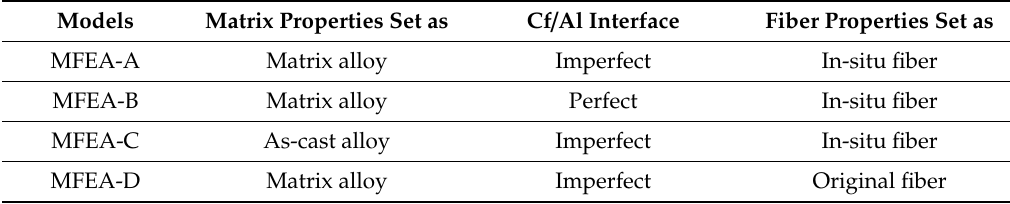
Table 7. Setting of the matrix, fiber and interface in the MFEA